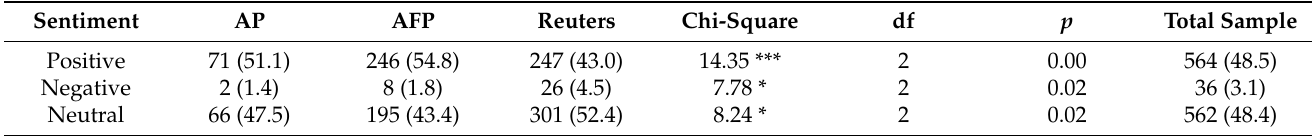
Table 7. News agencies’ sentiments regarding COVID-19